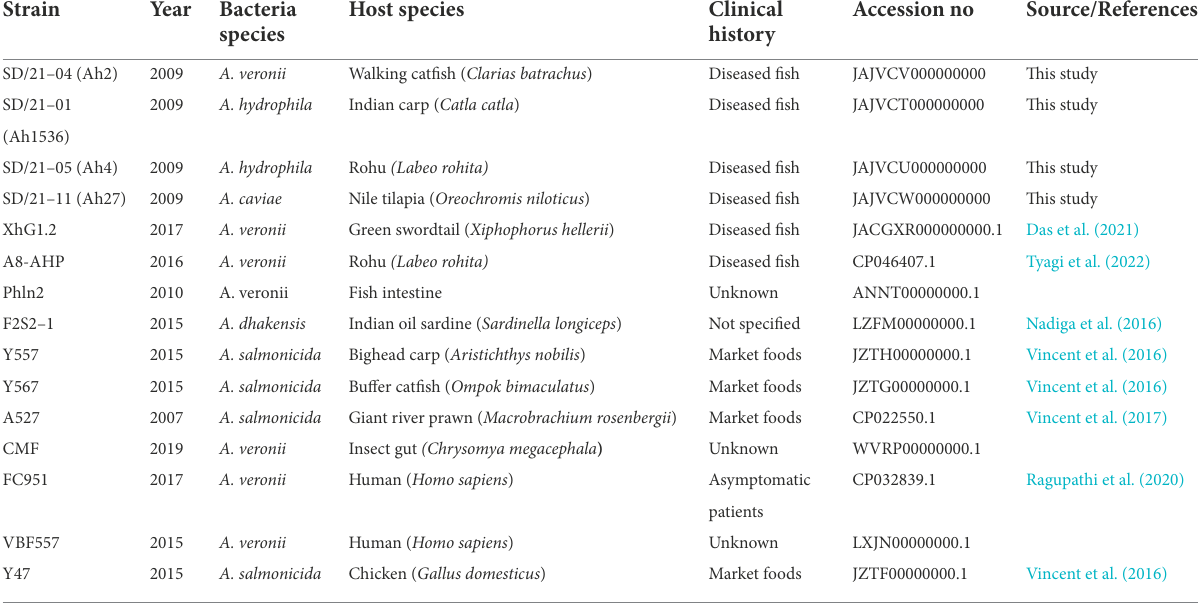
TABLE 1 Genebank accession numbers of Aeromonas spp. used in the study.